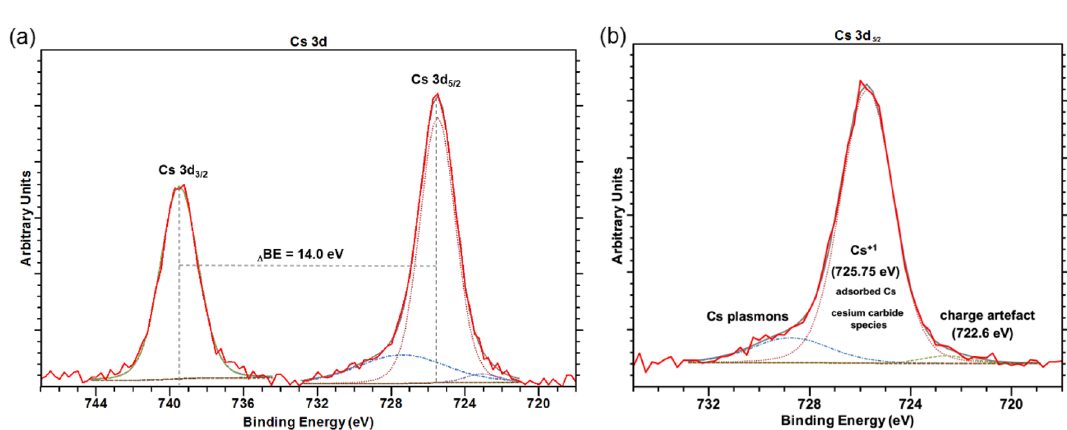
Figure 4. ( a ) Cs 3d photoemission spectrum of the activated p-GaN surface, showing the spin–orbit splitting at 14 eV and ( b ) Cs 3d 5 /2 photoemission spectrum of the adsorbed Cs on the p-GaN surface, with the peak fitting showing three components. The dashed lines represent the peak